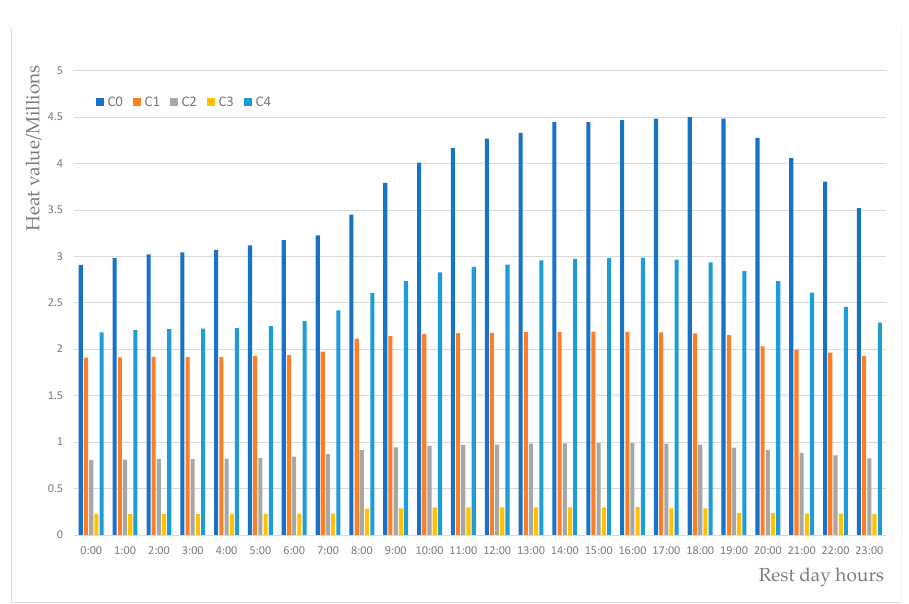
Figure 10. Population heat value of different areas in different time periods on weekdays.